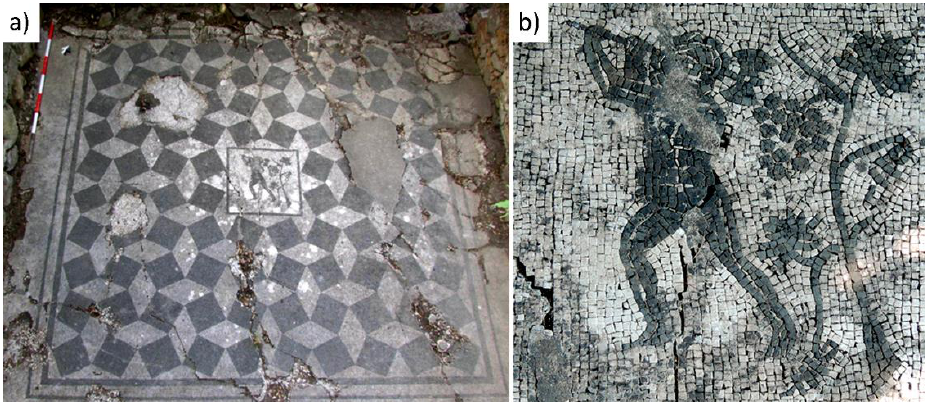
Figure 2. Domus 1, black and white mosaic of Room 1; ( a ) general view; and ( b ) particular view of the central pseudo-emblem.